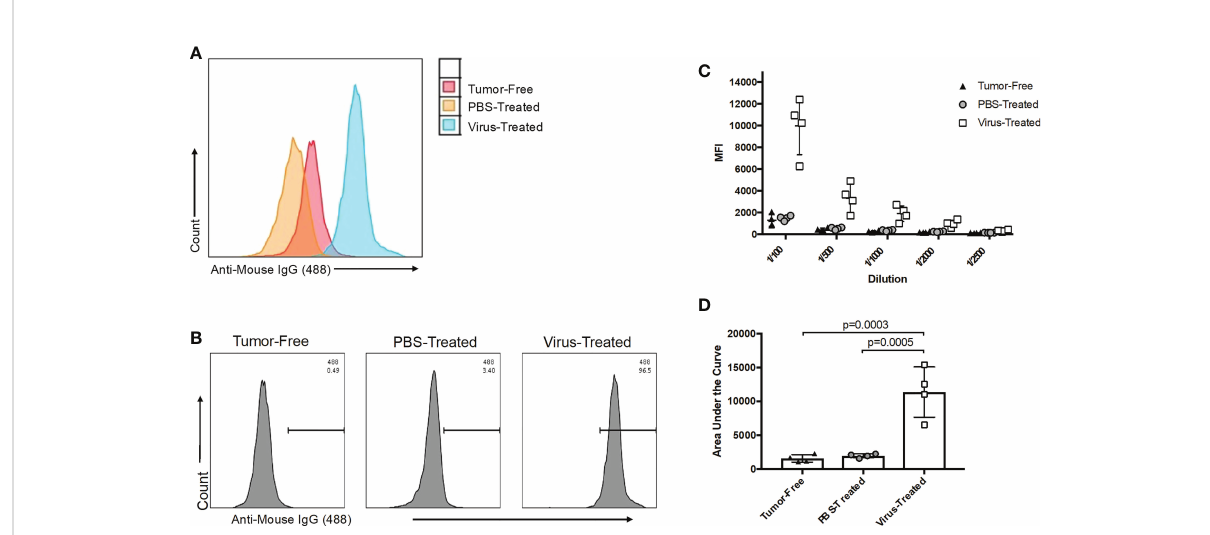
FIGURE 5 Evaluation of oncolytic virus (OV)-associated antibody responses. (A) Representative histogram overlay of target Vero cells infected for 16 hours with an OV and treated with a 1/100 dilution of plasma collected 21 days post-treatment from tumor-free (red), phosphate-buffered saline (PBS)-treated ID8 tumor-bearing (orange) or OV-treated ID8 tumor-bearing mice (blue) ( n =4 mice per group). OV-associated antibody binding was represented as a function of positive anti-mouse IgG1 Alexa Fluor 488 conjugated secondary antibody signals from targeted OV-infected cells. (B) Representative histograms of OV-associated antibodies binding to targeted OV-infected Vero cells. The antibodies were derived from plasma samples diluted 1/100 after collection from tumor-free, PBS-treated ID8 tumor-bearing or OV-treated ID8 tumor-bearing mice 21 days post-treatment. The data shown are representative of positive anti-mouse IgG1 Alexa Fluor 488 conjugated secondary antibody signals from OV-infected target cells. (C) Data derived from the fi ve-series dilution scheme (of which only one dilution was shown in panel B) were used to generate curves for each biological replicate. (D) Areas under the curves from data shown in panel C were calculated and used for comparison of virus-associated antibodies from the plasma of untreated tumor-free, PBS-treated, and OV-treated tumor-bearing mice. Statistical analysis was performed by one-way analysis of variance. Statistical signi fi cance was de fi ned as P-values less than or equal to